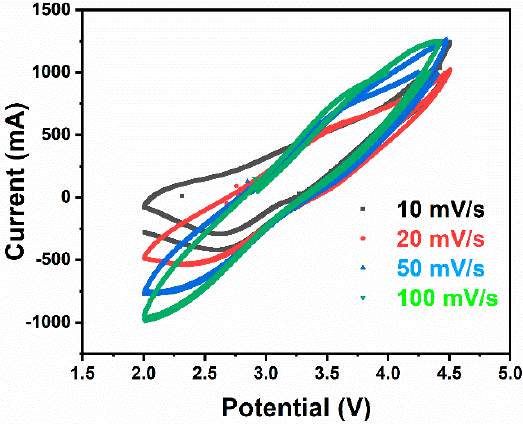
Figure A1. Cyclic voltammogram of NCAT4/Graphite cells.